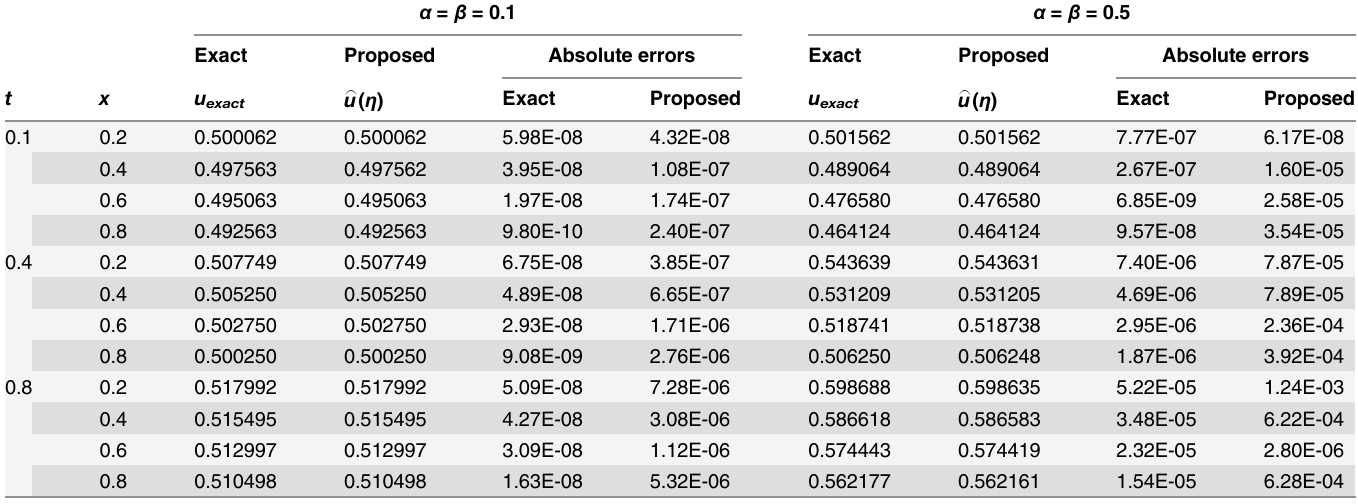
Table 8. Comparison of numerical solutions and absolute errors between the proposed scheme and HPM [12] for δ = 1 at different values of α and β . α = β =